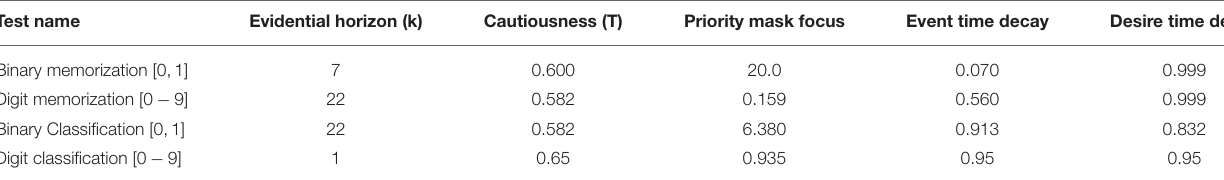
TABLE 2 | Configurable NARS parameters (up to 3 decimal places) used during each